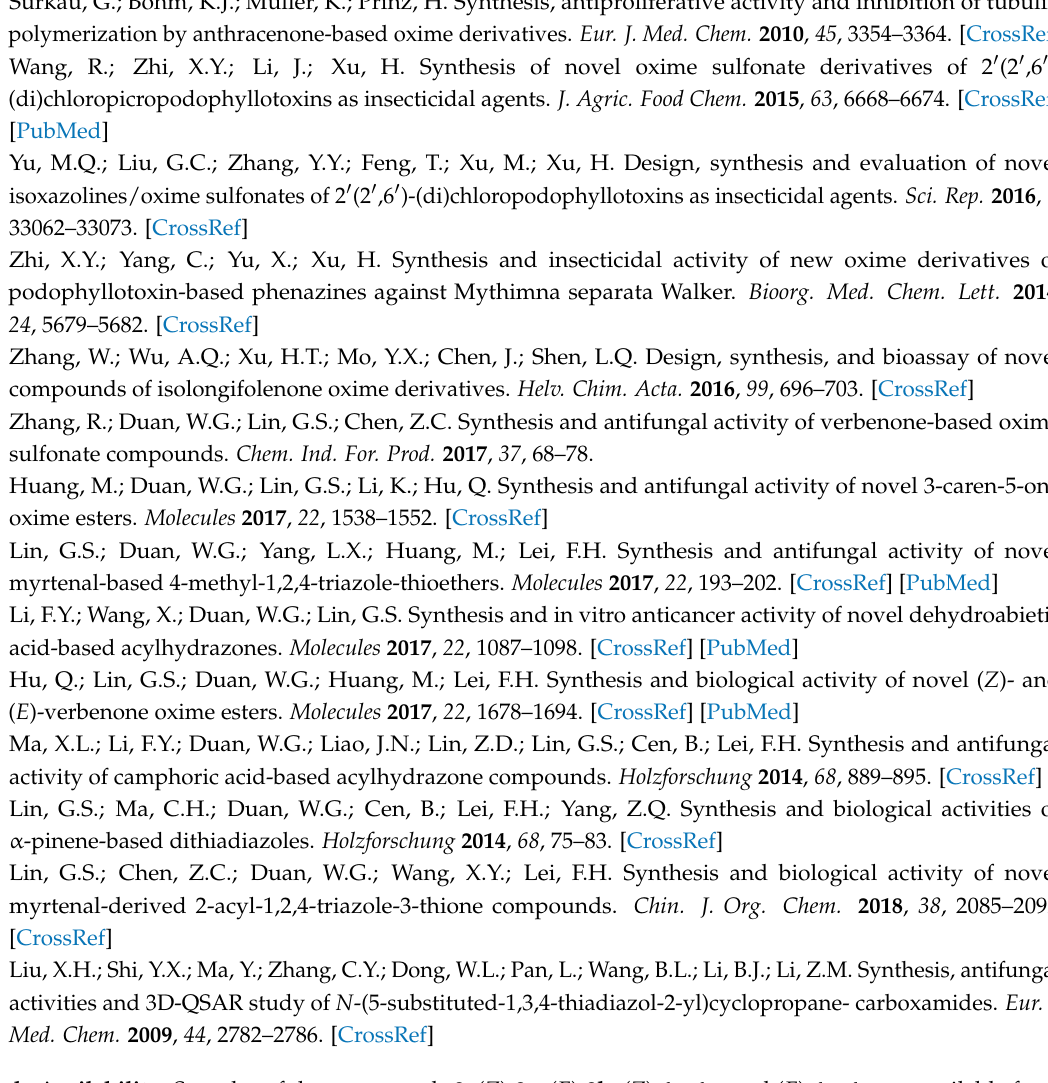
Sample Availability: Samples of the compounds 2 , ( Z )- 3a , ( E )- 3b, ( Z )- 4a – 4u, and ( E )- 4v – 4y are available from the